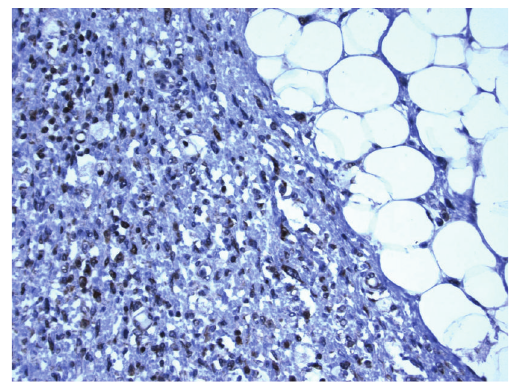
Figure 6: The tumor cells displayed di ff use immunoreactivity for